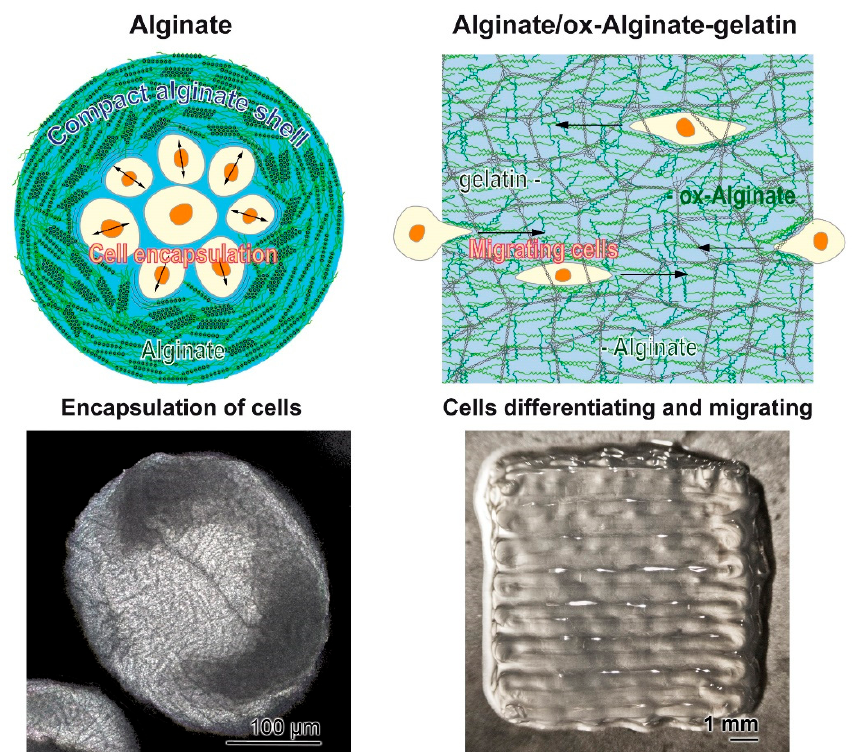
Figure 8. Schematic outline of alginate spheres ( left ) and alginate/oxidized-alginate-gelatin hybrid hydrogel ( right ). ( Left ) The natural alginate comprises a compact hydrogel that is ionically linked to a resistant protection of cells against external attacks. ( Right ) The alginate/oxidized-alginate-collagen hybrid material is a relatively soft hydrogel into which cells can migrate and proliferate. This material is designed as wound dressing.